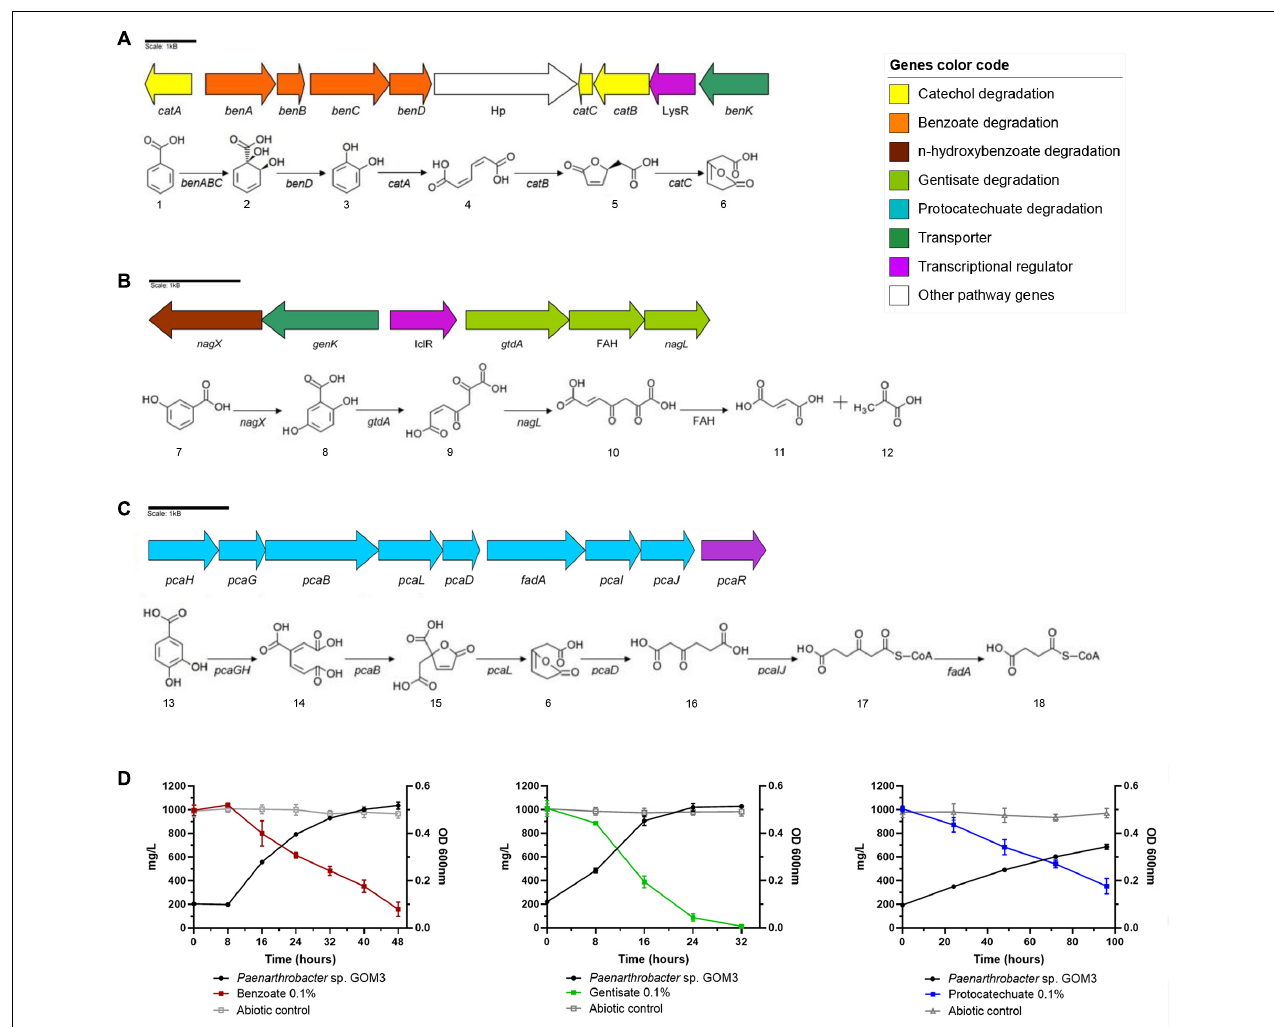
FIGURE 3 | Genomic and experimental evidence of aromatic compound degradation by Paenarthrobacter sp. GOM3. Degradation pathways and genomic context are shown for three aromatic compounds: (A) benzoate, (B) gentisate, and (C) protocatechuate. (D) Growth kinetics and decrease in its corresponding compound concentration. Whiskers represent the standard deviation of three biological replicates. Metabolic compounds: (1) benzoate; (2) cis-1,2-dihydroxycyclohexa-3,5-diene-1-carboxylate; (3) catechol; (4) cis,cis-muconate; (5) (+)-muconolactone; (6) 3-oxoadipate enol-lactone; (7) 3-hydroxybenzoate; (8) gentisate; (9) 3-maleylpyruvate; (10) 3-fumarylpyruvate; (11) fumarate; (12) pyruvate; (13) protocatechuate; (14) beta-carboxy-cis,cis-muconate; (15) gamma-carboxymuconolactone; (16) 3-oxoadipate; (17) 3-oxoadipyl-CoA; and (18) succinyl-CoA. Concentrations of each aromatic compound in abiotic controls in